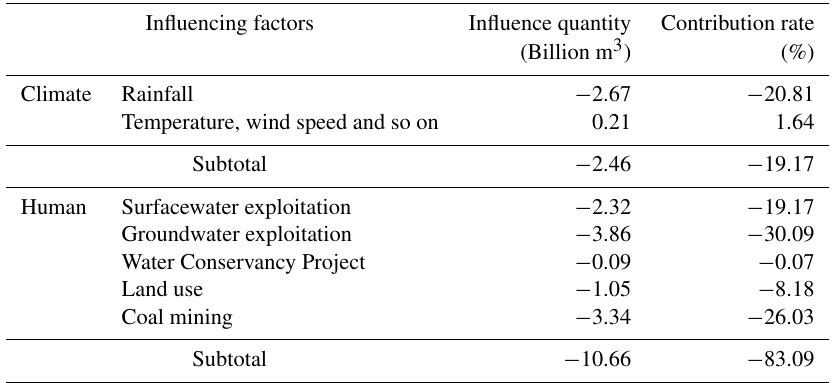
Table 3. The relative contribution of the factors affecting the natural runoff in the Fenhe River Basin from 1980 to